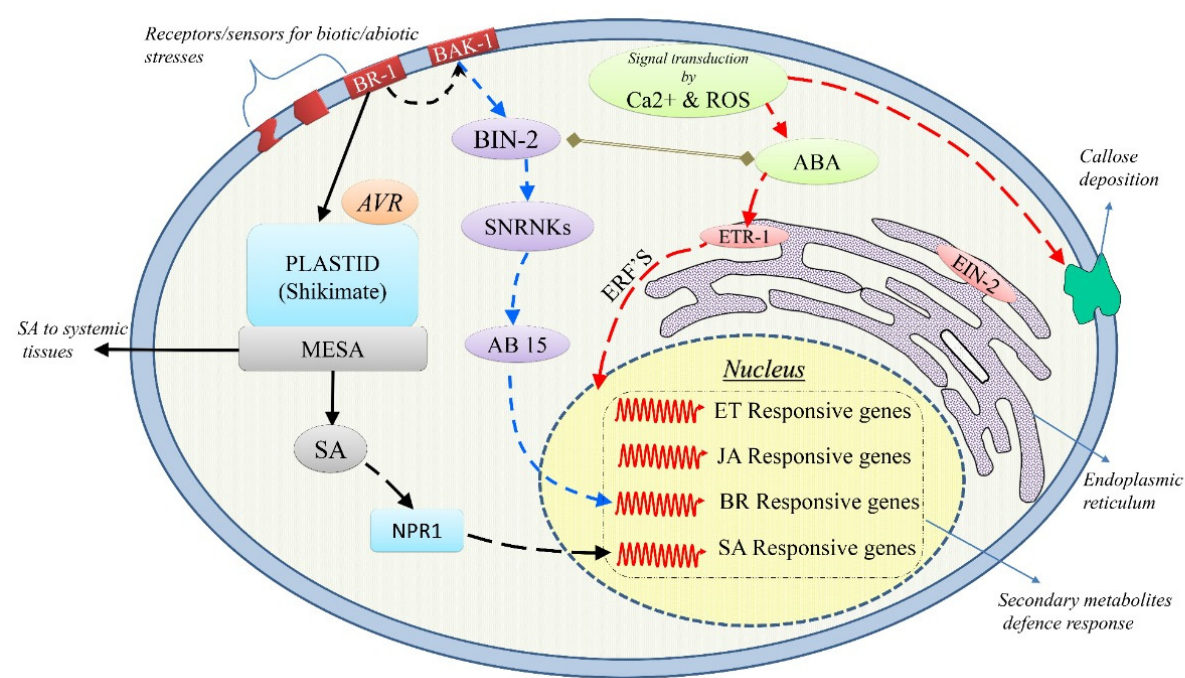
Figure 1. Possible role of plant hormones in stress cross-tolerance. The biotic and abiotic stress factors are first sensed by the plant cell membrane and are transduced to specific downstream signaling pathways. Reactive oxygen species (ROS) and Ca 2+ play major roles as messenger molecules that initiate ABA-mediated cell signaling. It was discovered that ethylene-insensitive 2 (EIN2) and ethylene-responsive genes (ETR) of Arabidopsis are involved in ABA responses. They activate the ethylene-responsive transcription factors (ERFs), which are key regulatory hubs that integrate ethylene, ABA, and jasmonate signaling and thereby their corresponding responsive gene transcription. Brassinosteroids are perceived by the extracellular domain of Brassinosteroid-insensitive 1 (BRI1)—a leucine-rich repeat kinase located in the plasma membrane. Upon perception, the intercellular serine–threonine kinase domain of BRI1 becomes phosphorylated and dissociates to form a complex with a second receptor kinase BRI1-associated receptor kinase BAK1. This transduces the signal by inactivating another kinase Brassinosteroid-insensitive 2 (BIN2), thus activating Abscisic acid-insensitive 5 (ABI5), a bzip transcription factor that regulates the transcription of ABA- and BR-responsive genes. Increased biosynthesis of SA occurs upon pathogen attack by effector perception via ICS/PAL pathway in plastids. Conversion of SA to methyl salicylate (MeSA) is catalyzed by SA methyltransferase (SAMT). MeSA diffuses into the cytoplasm, where it is converted back to SA and is distributed to the systemic tissues. Increased levels of SA in the cytoplasm lead to the disruption of oligomeric NPR1 into its monomers, migrating to the nucleus to activate transcription of SA-responsive defense genes including PR genes.